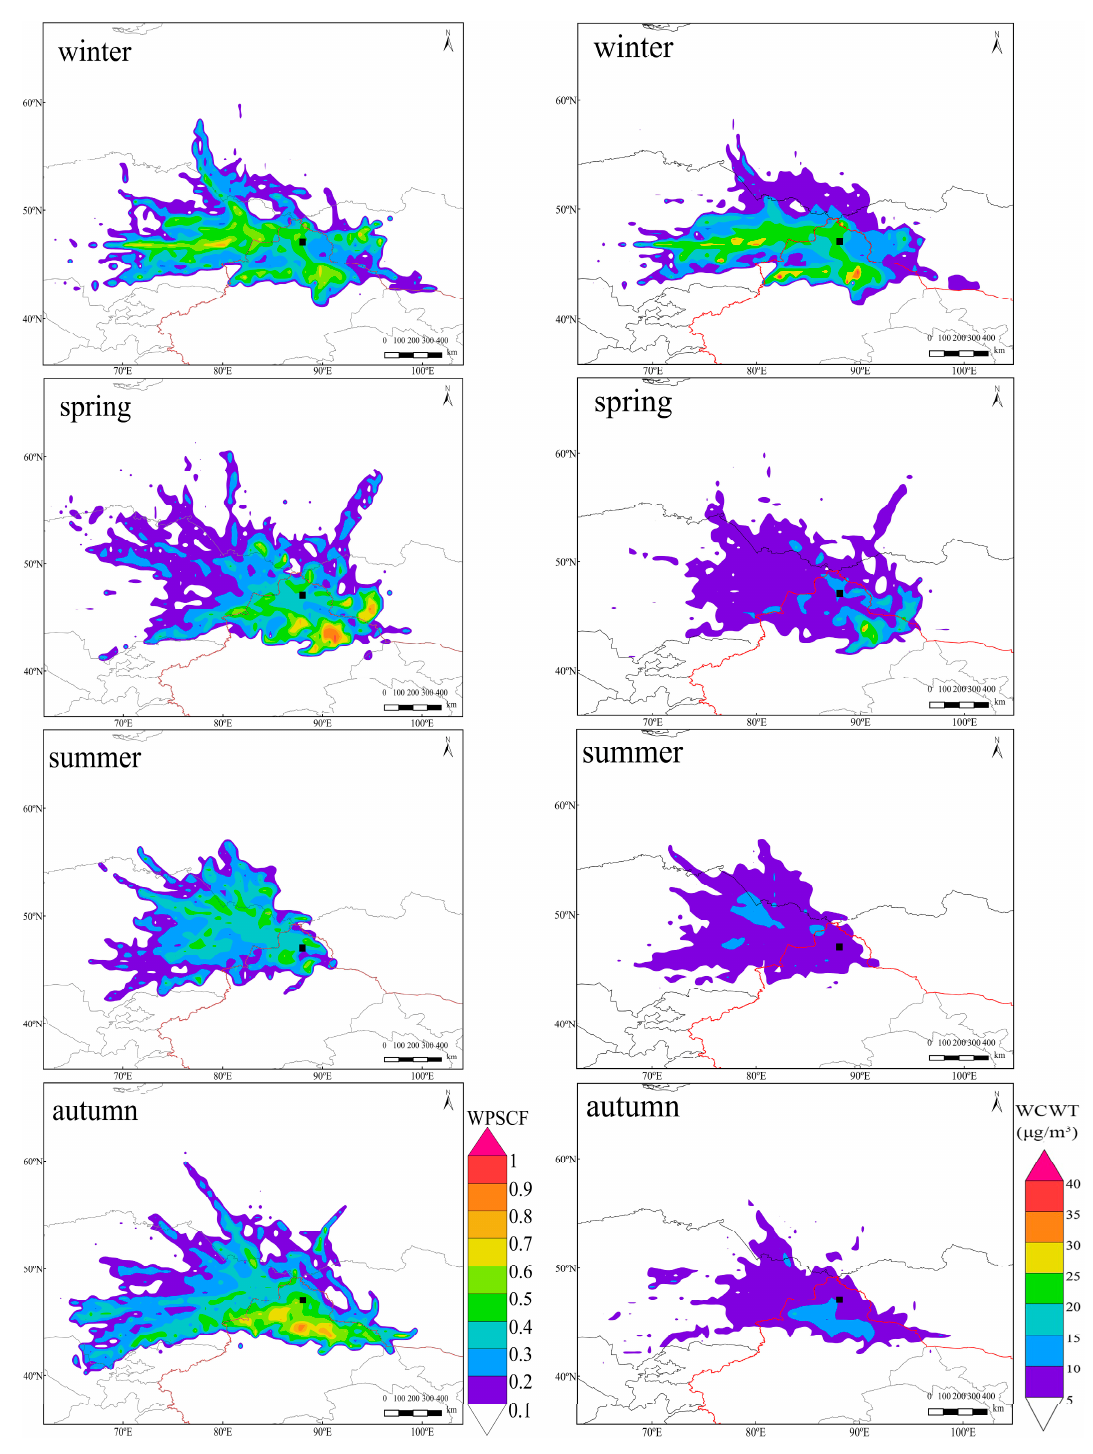
Figure 6. WPSCF and WCWT maps of PM 2.5 in winter, spring, summer, and autumn from January 2017 to December 2019. The black square represents Akedala. WPSCF: Weighted Potential Source Contribution Function. WCWT: Weighted Concentration-Weight Trajectory.